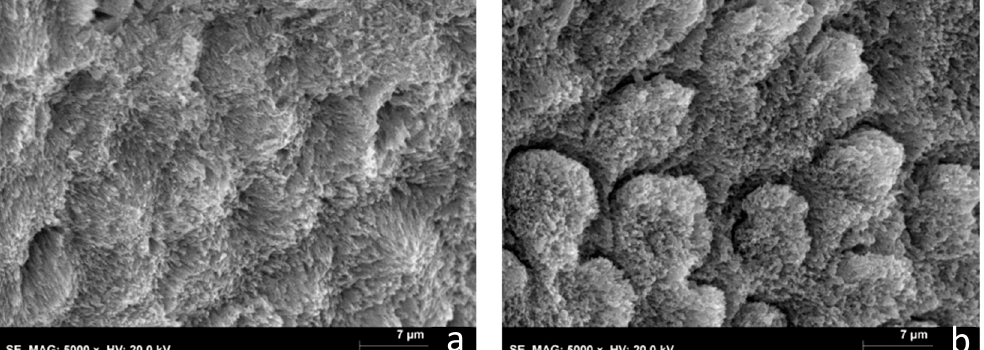
Figure 5. MIH specimens’ SEM photograph (5000×). ( a ) Group D—white hypomineralized opacities; ( b ) Group G—white hypomineralized opacities after CPP-ACP protocol.